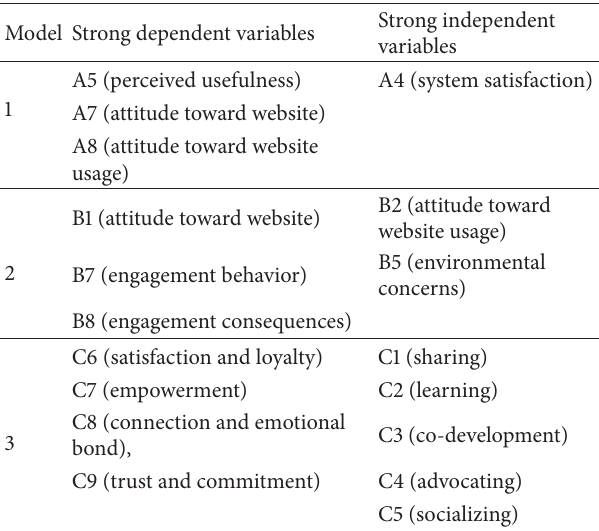
Table 12: Cause and effect factors identified by ISM model. Table 13: Cause and effect factors identified by DEMATEL